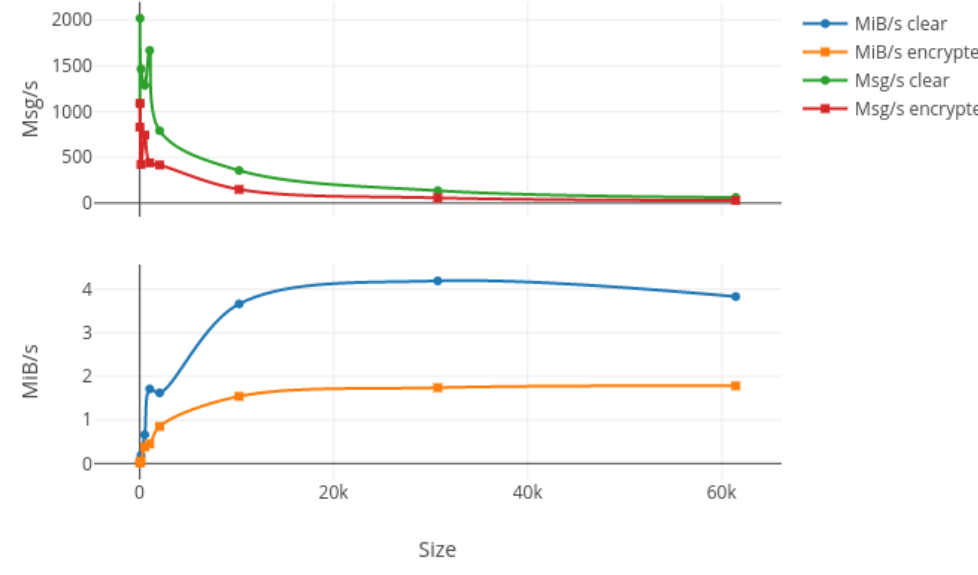
Figure 8. Bandwidth results in terms of Msg/s and MiB/s for 10,000 packets sent on the Raspberry Pi 3 hardware with increasing message size in both encrypted and clear mode.